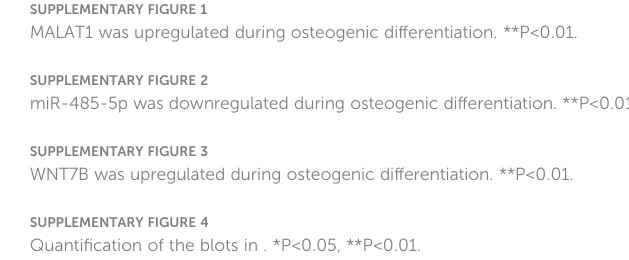
SUPPLEMENTARY FIGURE 1 MALAT1 was upregulated during osteogenic differentiation. **P<0.01. SUPPLEMENTARY FIGURE 2 miR-485-5p was downregulated during osteogenic differentiation. **P<0.01. SUPPLEMENTARY FIGURE 3 WNT7B was upregulated during osteogenic differentiation. **P<0.01. SUPPLEMENTARY FIGURE 4 Quanti fi cation of the blots in . *P<0.05, **P<0.01. SUPPLEMENTARY FIGURE 5 miR-485-5p aggravated inhibitory effects of MG on osteogenic differentiation. The MG treated MC3T3-E1 cell was transfected with miR-485-5p mimic. (A) The expression of ALP was detected by RT-qPCR. (B) The expression of Bglap, Runx2, and Col1a1 was detected by RT-qPCR. (C) The protein expression of Bglap, Runx2, and Col1a1 was detected by western blot. (D) The ALP activity of MC3T3-E1 cells. (E) The calcium deposit detected using Alizarin red staining. (F) The apoptosis of MC3T3-E1 cells detected using fl ow cytometry. (G) The protein expression of Bax, Caspase-3, and Bcl-2 detected using western blot. *P<0.05, **P<0.01. SUPPLEMENTARY FIGURE 6 WNT7B knockdown aggravated inhibitory effects of MG on osteogenic differentiation. The MG treated MC3T3-E1 cell was transfected with si- WNT7B. (A) The expression of ALP was detected by RT-qPCR. (B) The expression of Bglap, Runx2, and Col1a1 was detected by RT-qPCR. (C) The protein expression of Bglap, Runx2, and Col1a1 was detected by western blot. (D) The ALP activity of MC3T3-E1 cells. (E) The calcium deposit detected using Alizarin red staining. (F) The apoptosis of MC3T3-E1 cells detected using fl ow cytometry. (G) The protein expression of Bax, Caspase-3, and Bcl-2 detected using western blot. *P<0.05, **P<0.01. SUPPLEMENTARY FIGURE 7 WNT7B knockdown reversed the promoting effects of miR-485-5p inhibitor on osteogenic differentiation in MC3T3-E1 cells. The MC3T3-E1 cell was transfected with si-WNT7B and miR-485-5p inhibitor. (A) The expression of ALP was detected by RT-qPCR. (B) The expression of Bglap, Runx2, and Col1a1 was detected by RT-qPCR. (C) The protein expression of Bglap, Runx2, and Col1a1 was detected by western blot. (D) The ALP activity of MC3T3-E1 cells. (E) The calcium deposit detected using Alizarin red staining. (F) The apoptosis of MC3T3-E1 cells detected using fl ow cytometry. (G) The protein expression of Bax, Caspase-3, and Bcl-2 detected using western blot. *P<0.05,